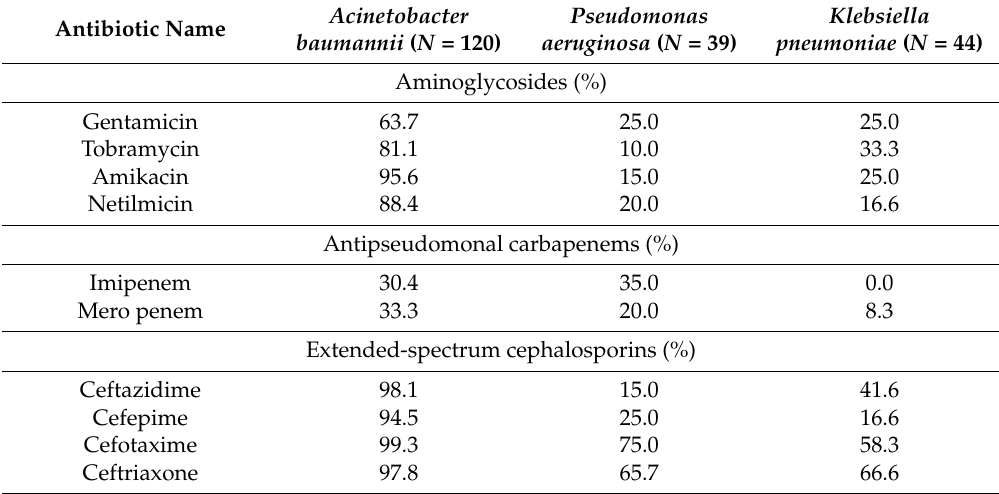
Table 6. Resistance to a selected group of antibiotics and type of multi-drug resistance in the ICU in the years